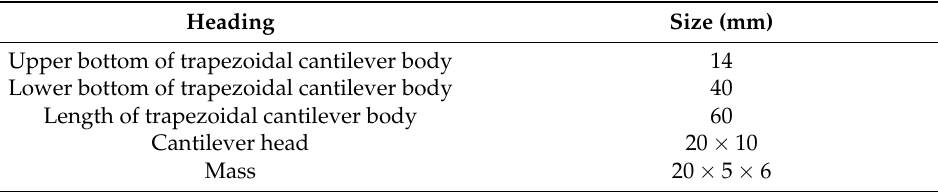
Table 2. Structural sizes and parameters of piezoelectric patch. Components of the